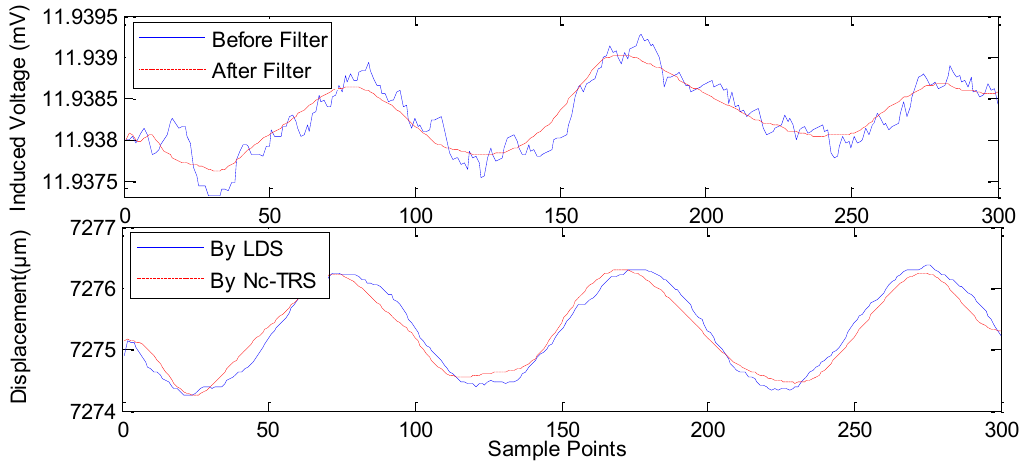
Figure 11. The sensing effect under applied current I ( t ) = 0.1sin(2  ft ) A ( f = 10